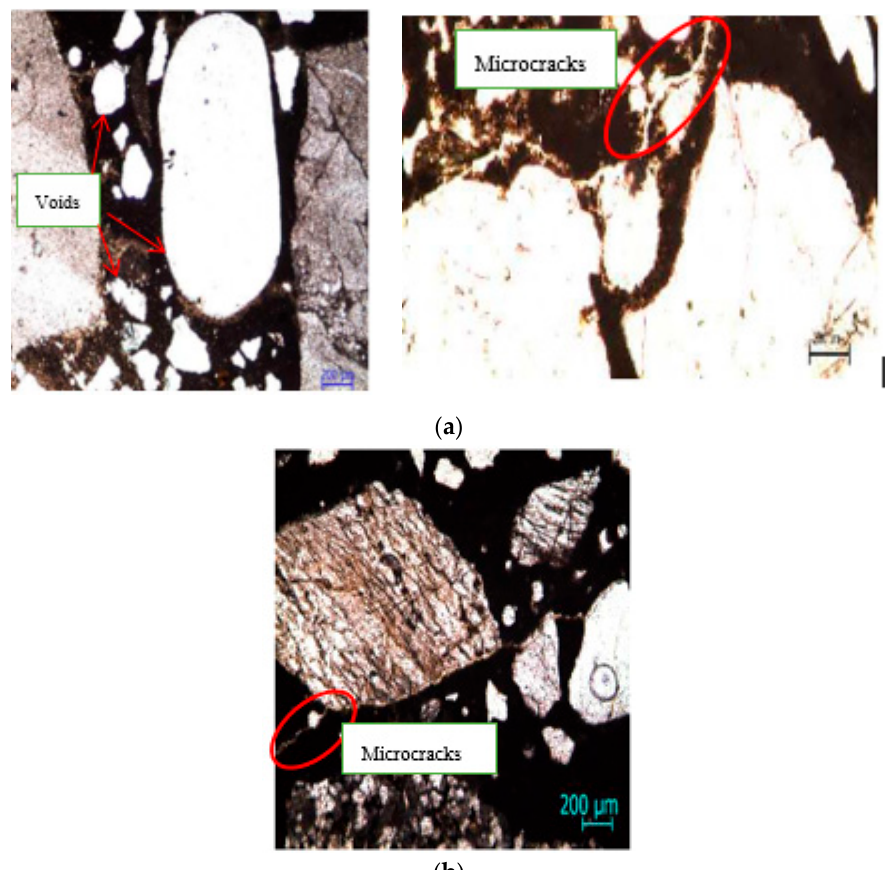
Figure 8. Photomicrograph of concrete [15]: ( a ) without calcium stearate; ( b ) with calcium stearate.